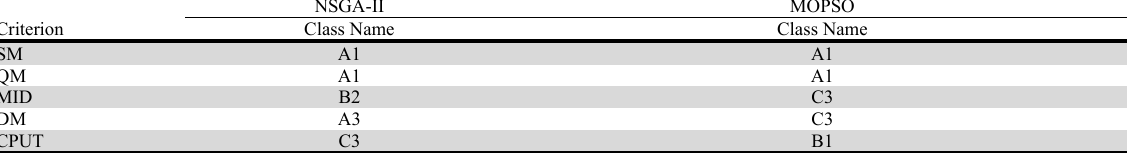
Fig. 21 Mean value for the two algorithms in medium and large scale sample problems for each class The best classes achieved by Mean value and Standard Error for medium and large scale sample